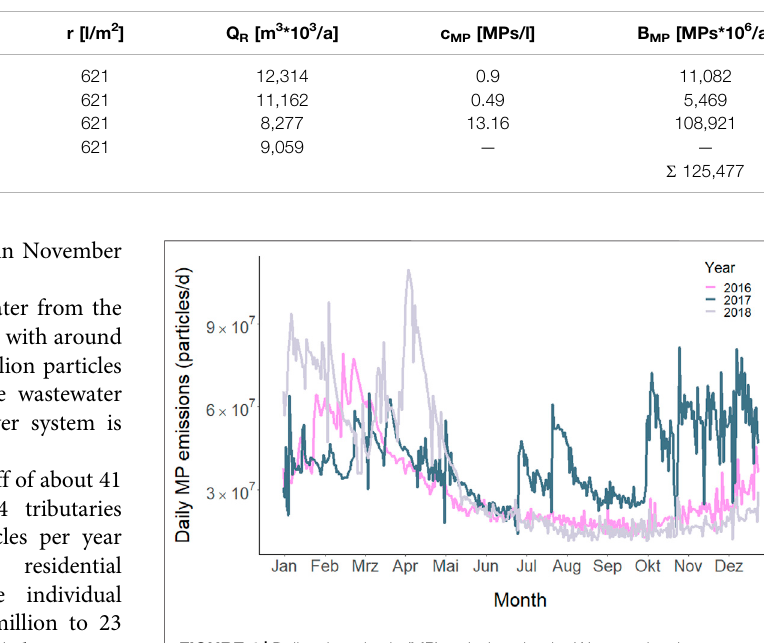
FIGURE 4 | Daily microplastic (MP) emissions by the Warnow river into the estuary calculated based on a linear relationship (F (cid:1) 11.04, adj. R 2 (cid:1) 0.6, p (cid:1) 0.016; y (cid:1) 132.41 + 18.62*x) of measured MP abundances in water surface (n (cid:1) 8) and river discharge (data provided by Staatliches Amt für Landwirtschaft und Umwelt Mittleres Mecklenburg